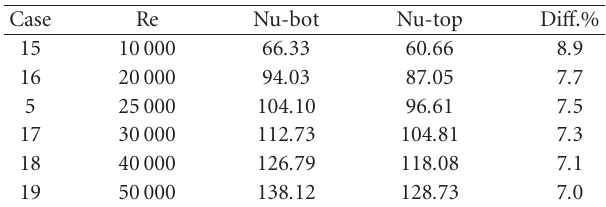
Table 2: Average Nusselt numbers over the top and bottom walls of the cooling channel for ˙ m r = 1 / 2 and di ff erent Reynolds